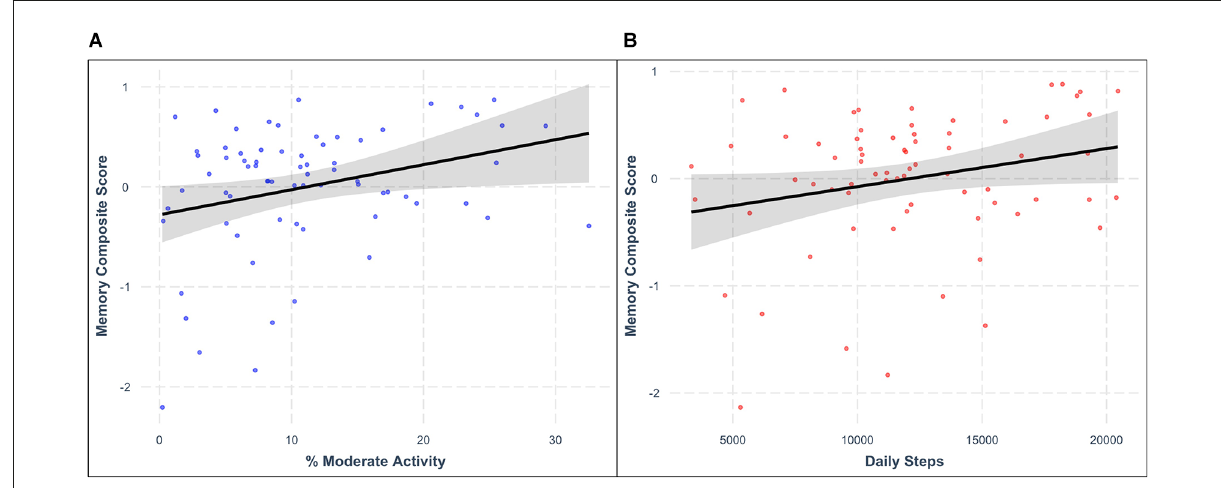
FIGURE2 Relationships between memory composite score and (A) average percentage of time spent in moderate physical activity ( β = 0.232, p = 0.027) and (B) average daily steps ( β = 0.209, p = 0.037) after controlling for relevant covariates. Shaded areas represent the 95% confidence interval for each regression